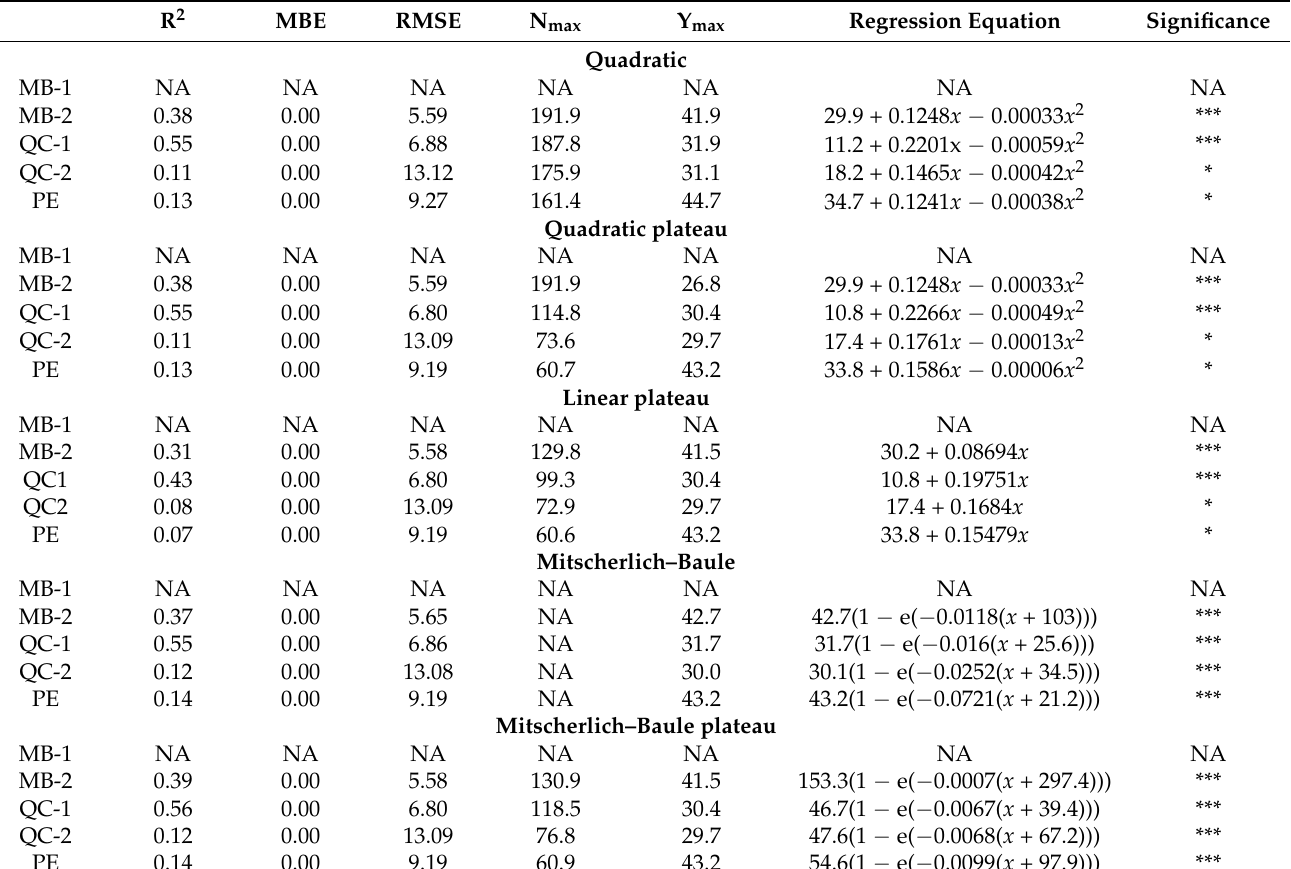
Table 8. Maximum nitrogen rate (N max ) to obtain maximum marketable yield (Y max ) by fitting the data with five models ( n = 60). R 2 MBE Regression Equation